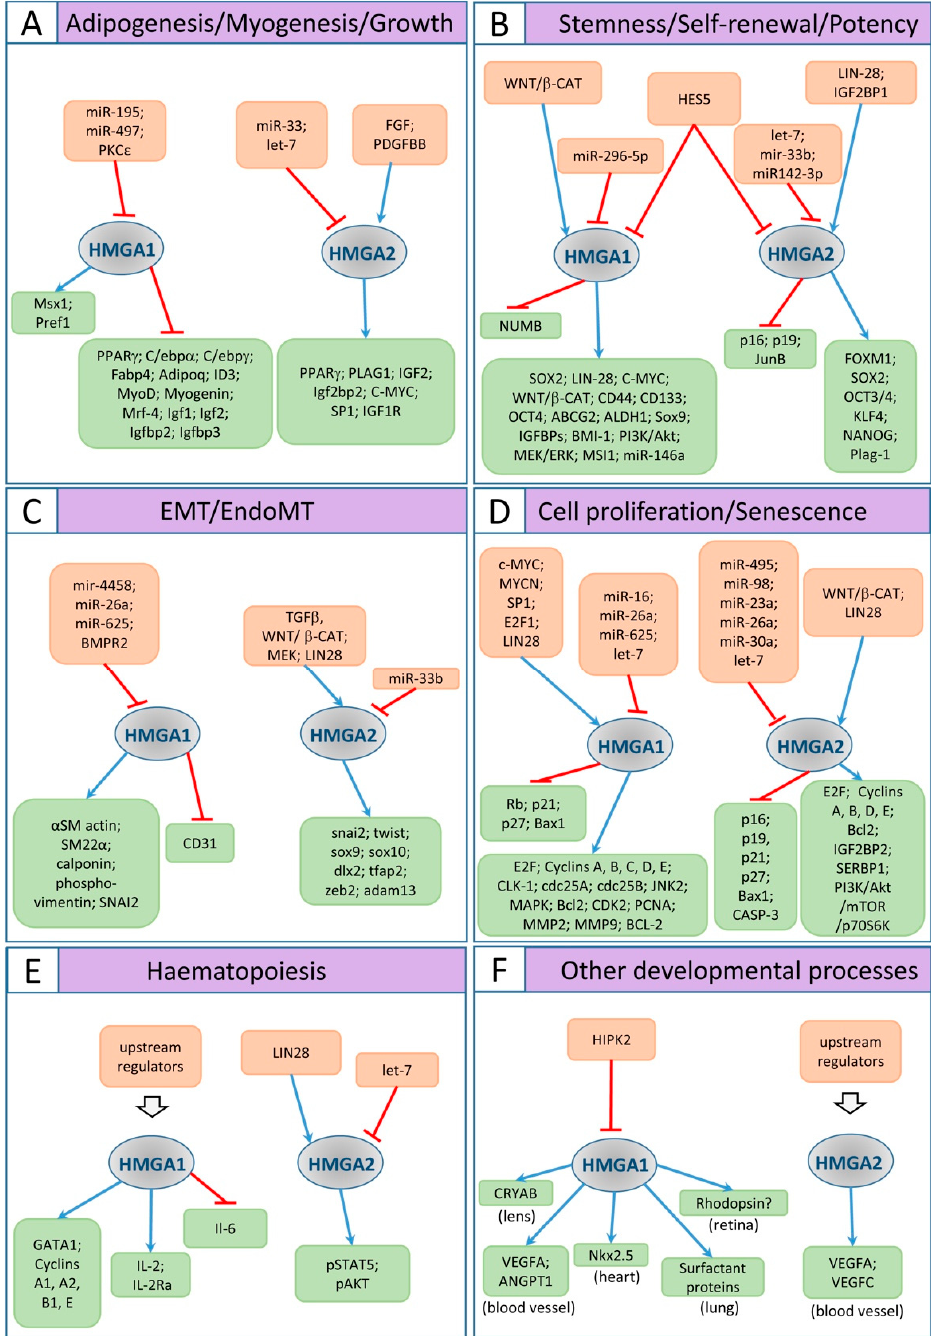
Figure 3. Schematic representation of the HMGA1/2 pathways involved in the cell and developmental biology processes described in the text. Orange boxes include regulators of HMG1/2 proteins; green boxes include molecules regulated by HMG1/2. Blue arrows indicate positive regulation; red bars point out negative regulation. ( A ) adipogenesis, myogenesis, and growth; ( B ) stemness/self-renewal/potency; ( C ) EMT and EndoMT; ( D ) cell proliferation and senescence; ( E ) hematopoiesis; ( F ) other developmental aspects.